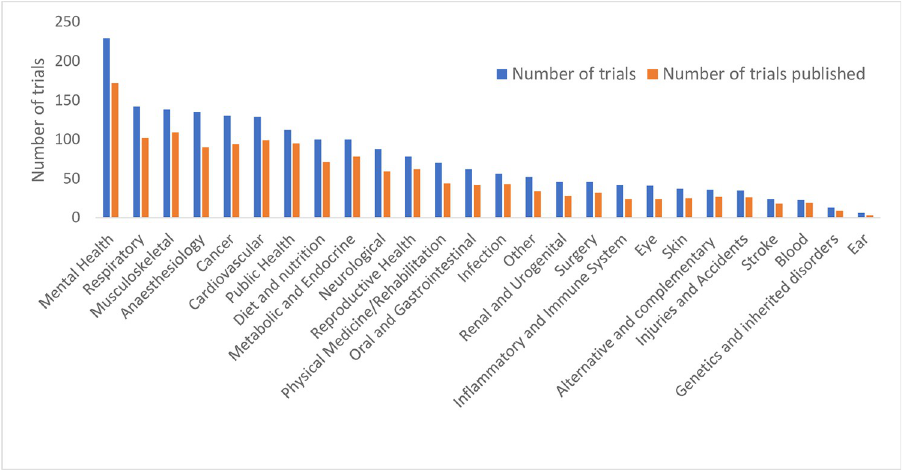
Fig 5. Health conditions associated with ANZCTR trial registrations, number, and publication rate (n = 1,970).